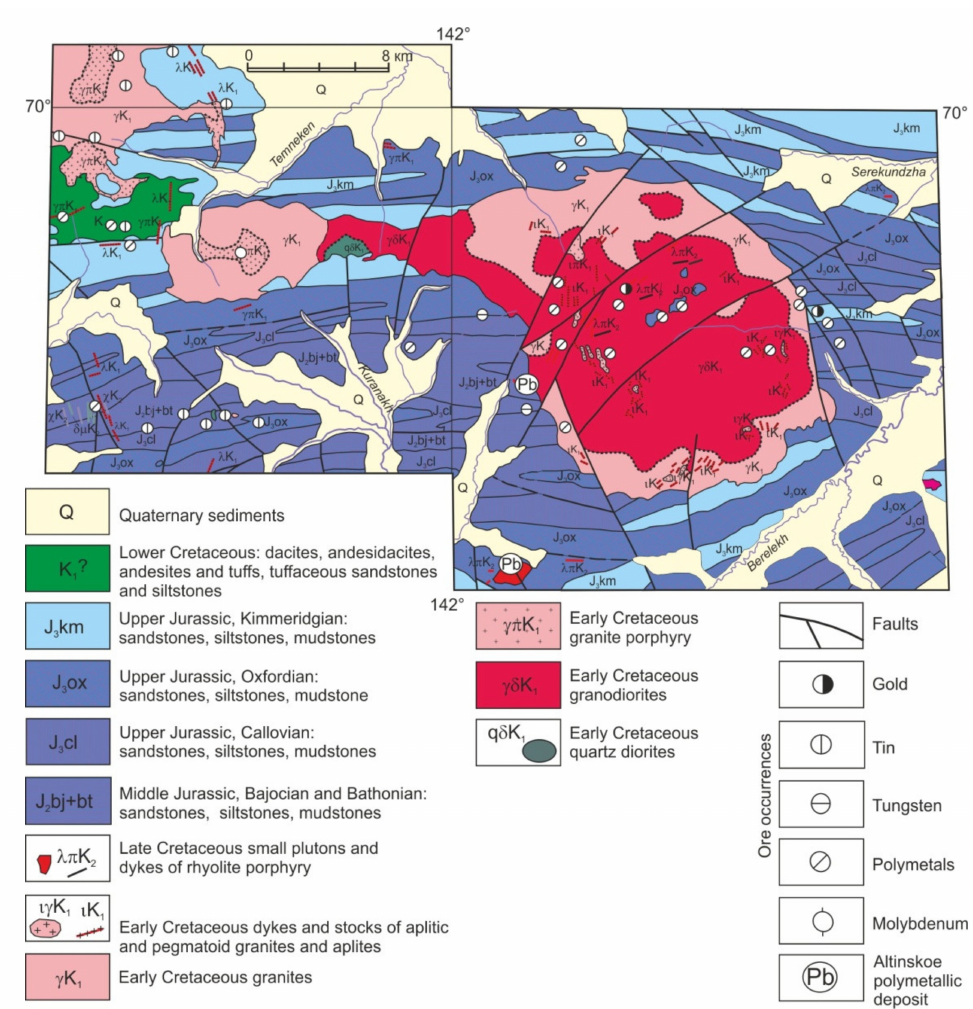
Figure 3. Geological map of the Kuranakh ore field, modified from